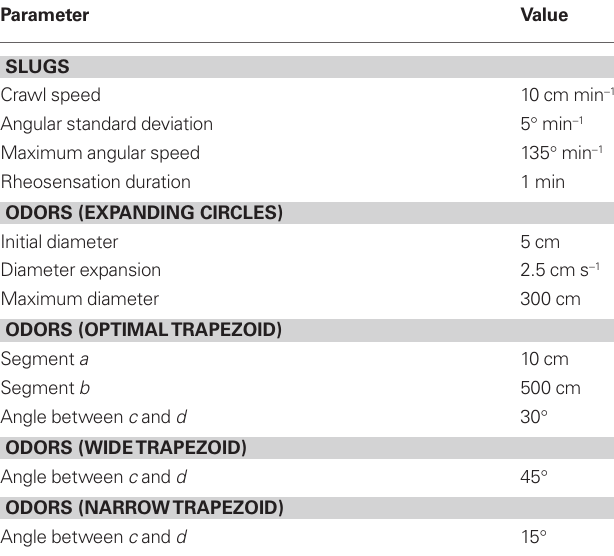
Table 1 | Simulation parameters.